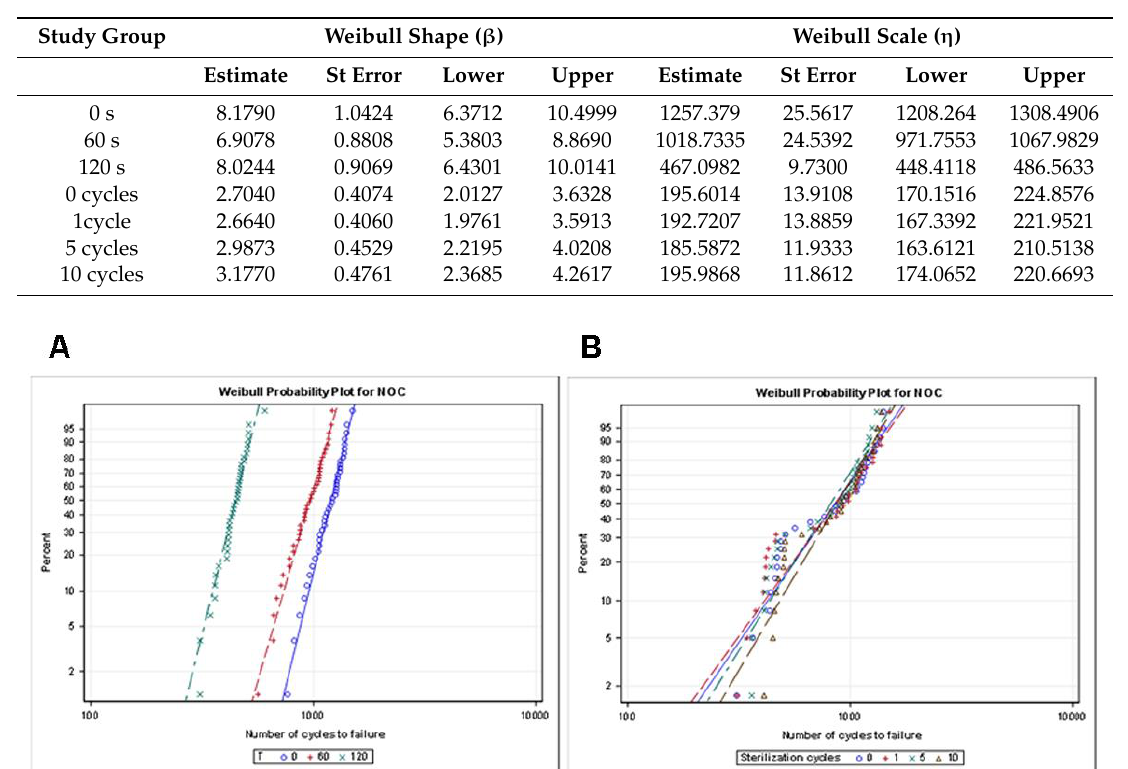
Table 5. Descriptive statistics of the number of cycles of in-and-out movement for the time of use and sterilization cycles study groups.